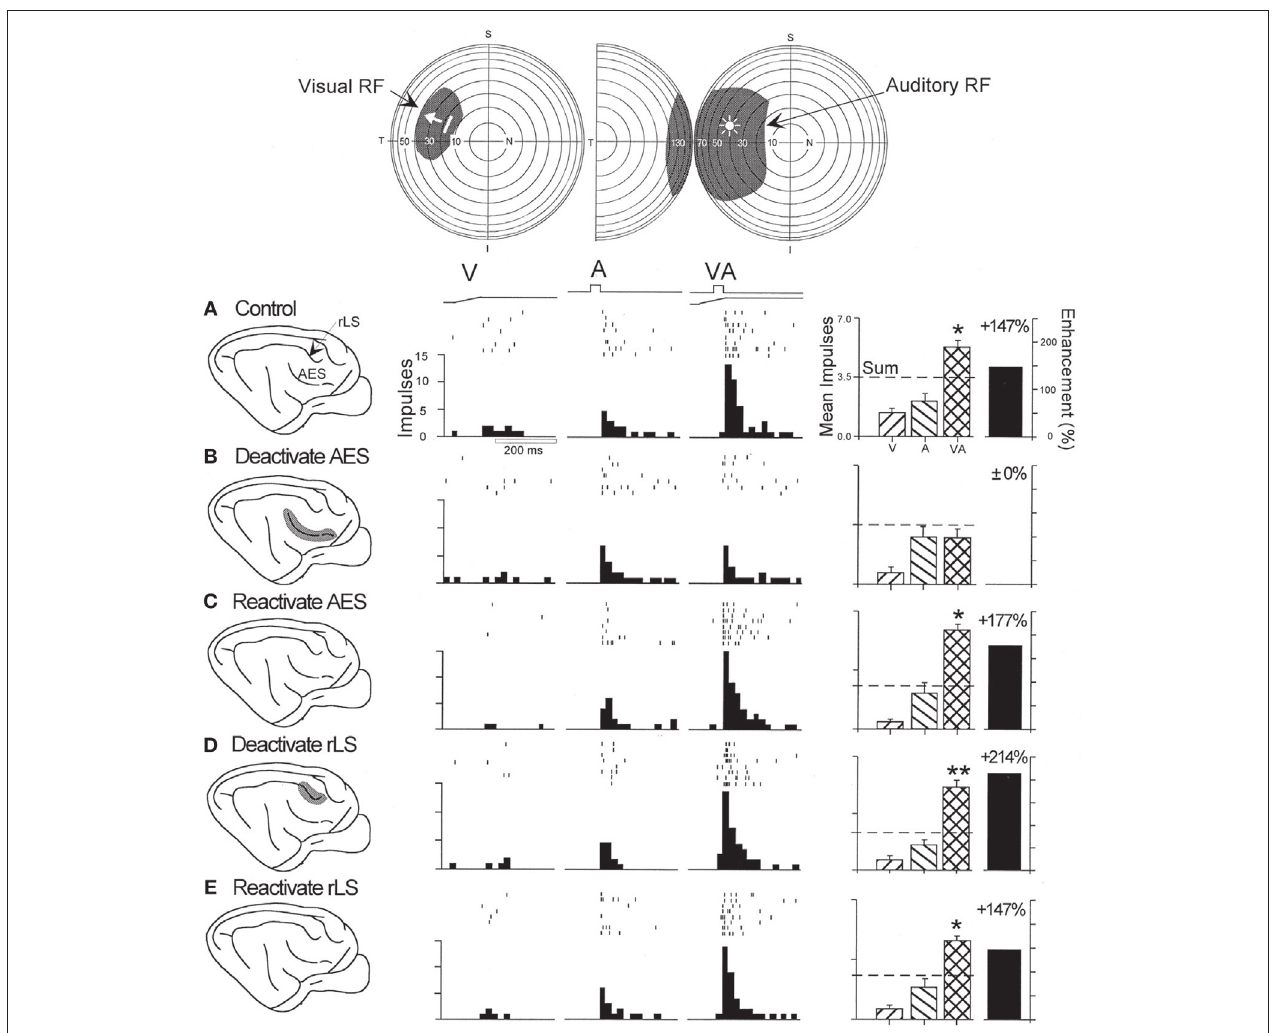
FIGURE 2 | The multisensory enhancement of many SC neurons depends exclusively on infl uences from AES. Top : the visual and auditory receptive fi elds of this neuron are depicted by the shaded areas on the illustrations of visual and auditory space with the same stimulus conventions as in Figure 1 . Bottom : (A) Shown are the neuron’s responses to the individual modality- specifi c stimuli and to their co-presentation before cortical deactivation (“control”). The movement of the visual stimulus is represented by the ramp labeled “V” and the auditory stimulus by the square wave labeled “A”. Below each stimulus trace are rasters and peristimulus time histograms that illustrate the neuron’s responses. Although the neuron showed a slightly better response to the auditory than to the visual stimulus, its best response was obtained when